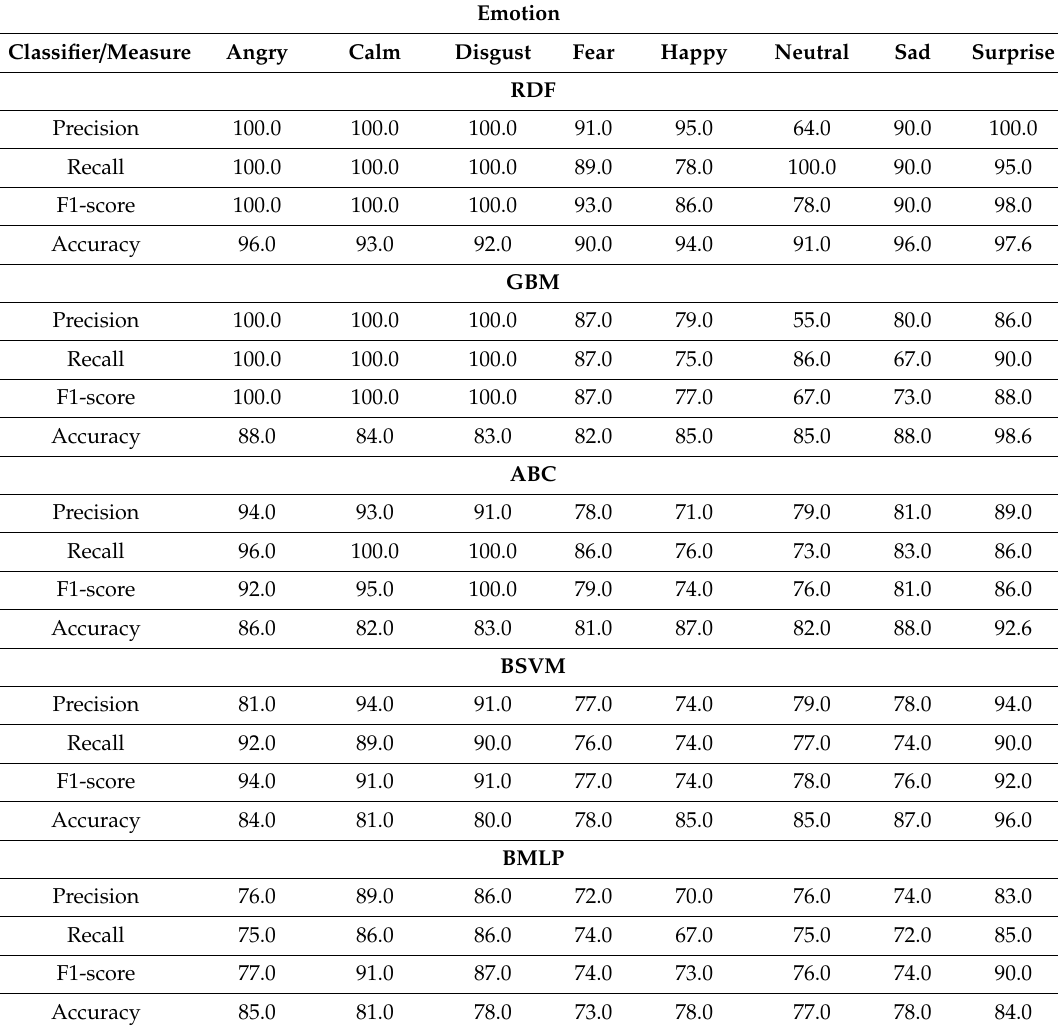
Table 6. Percentage precision, recall and F1-score and accuracy on RAVDESS